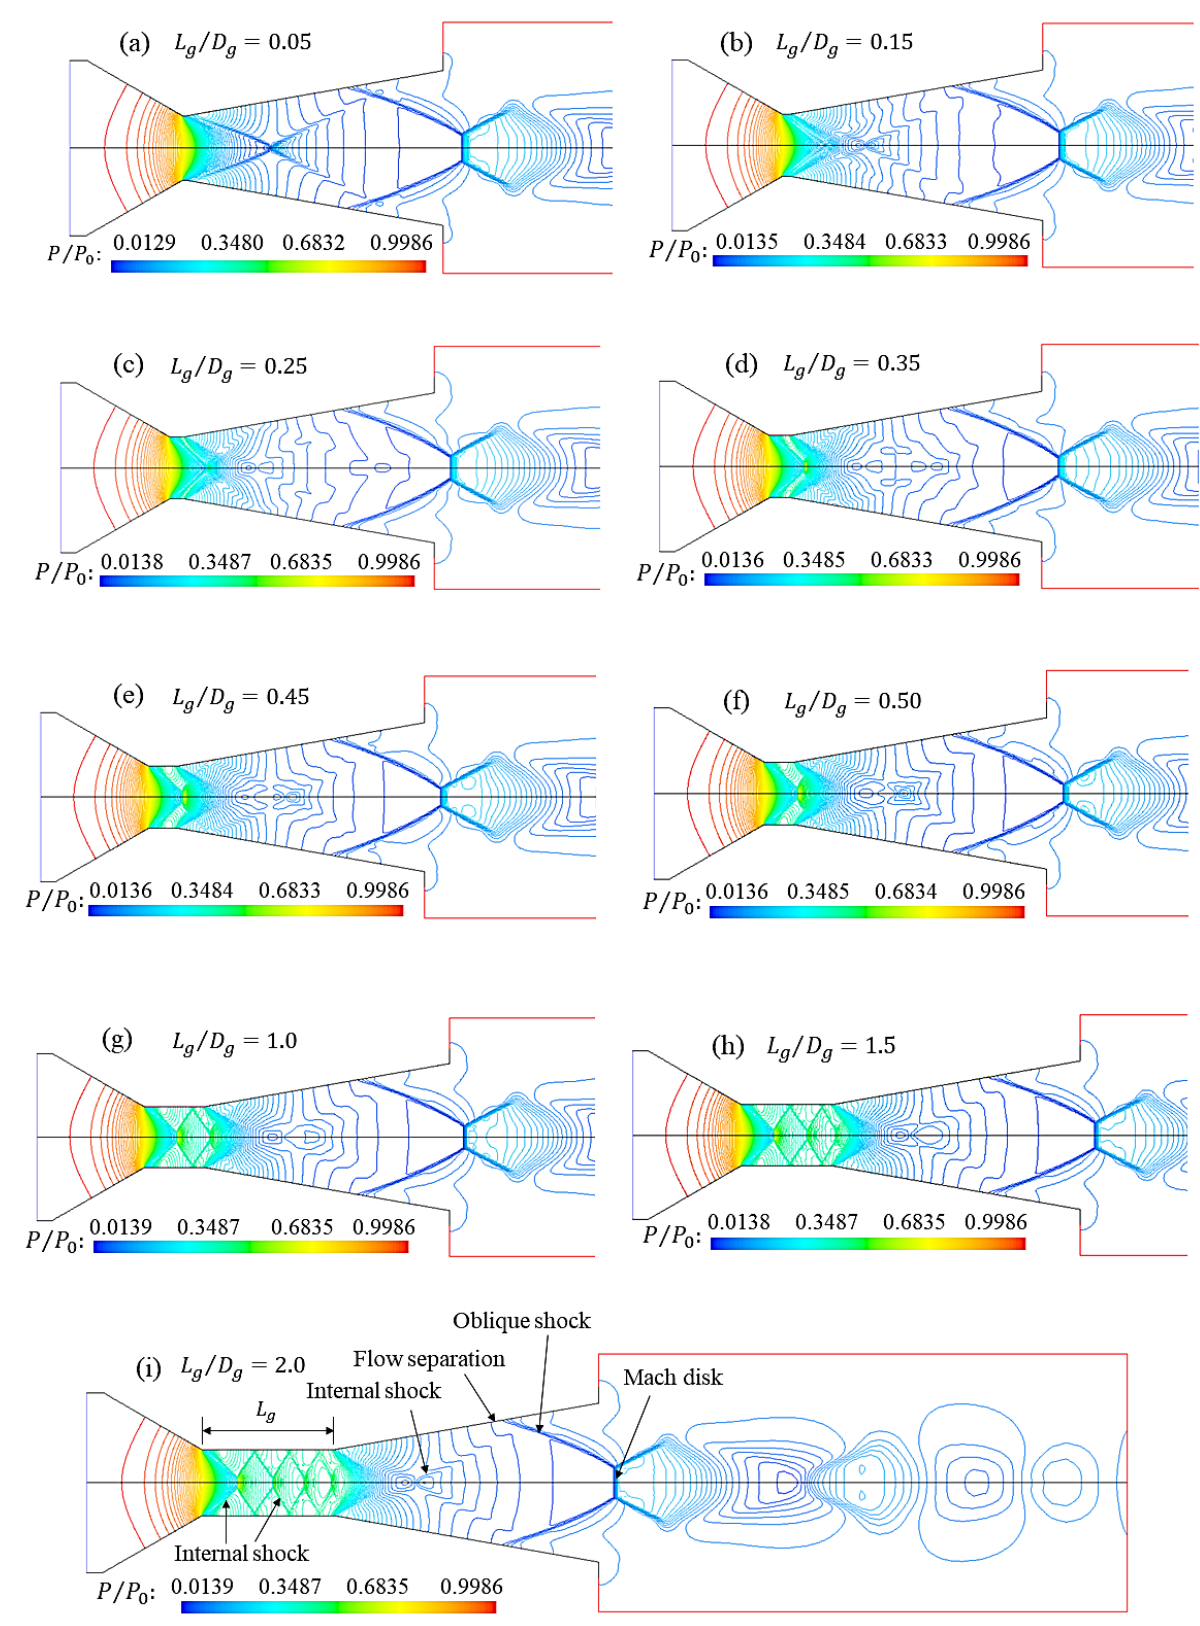
Figure 5. Flow field with presence of shock waves: pressure contour lines. Conical nozzle throat length in the range 0.05 ≤ L g /D g ≤ 2. Source: